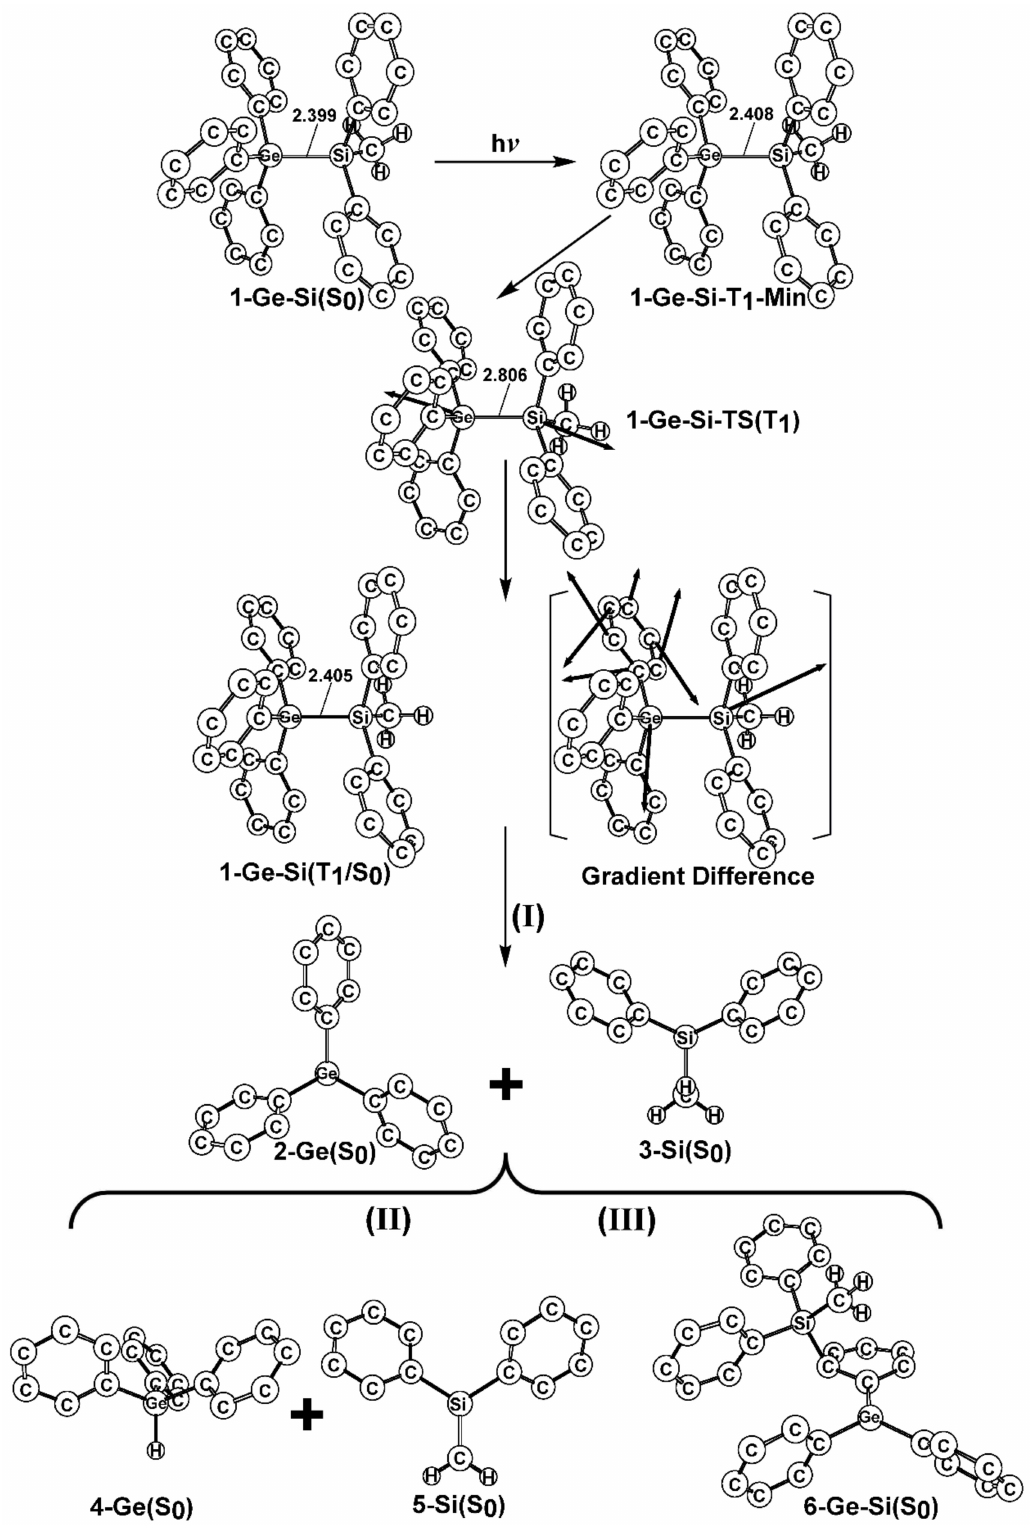
Figure 5. The optimized structures for the photochemical isomerization model of Ph 3 Ge–SiPh 2 Me at the M06-2X/6-311G(d) level of